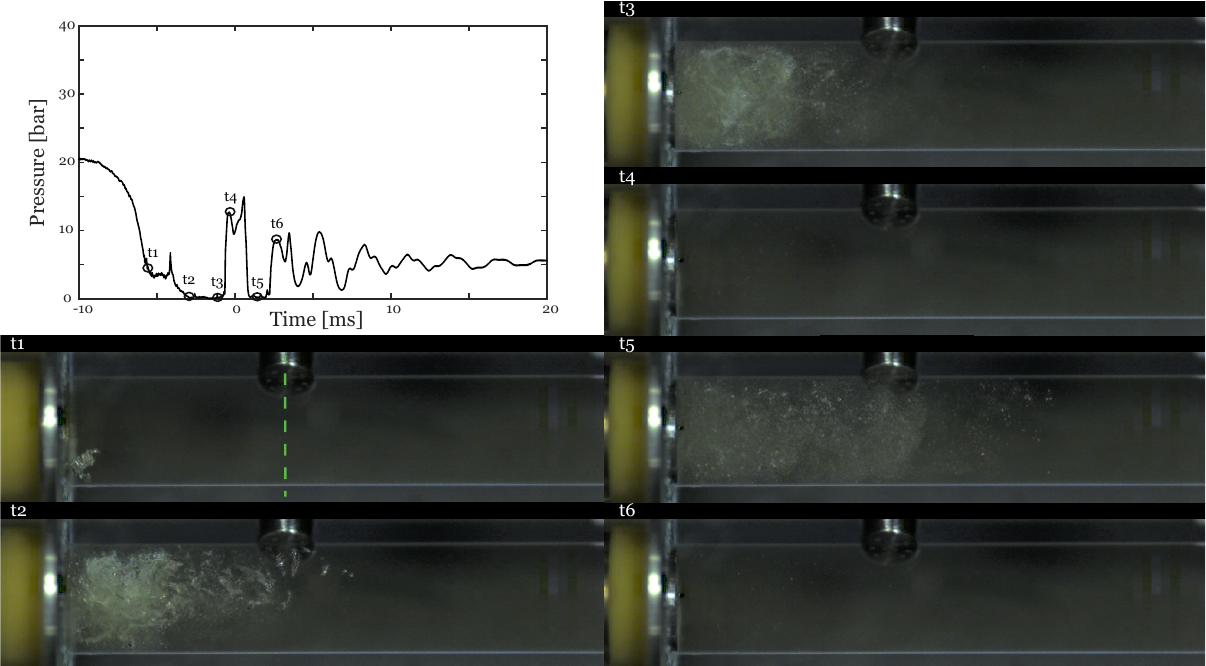
Figure 6. High-speed camera images of the vapor cavities after valve closing for Re = 1633 at different snapshots (t1 to t6). The graph inset shows the corresponding pressure response at P1 (green dashed line in t1). For camera settings, see Table